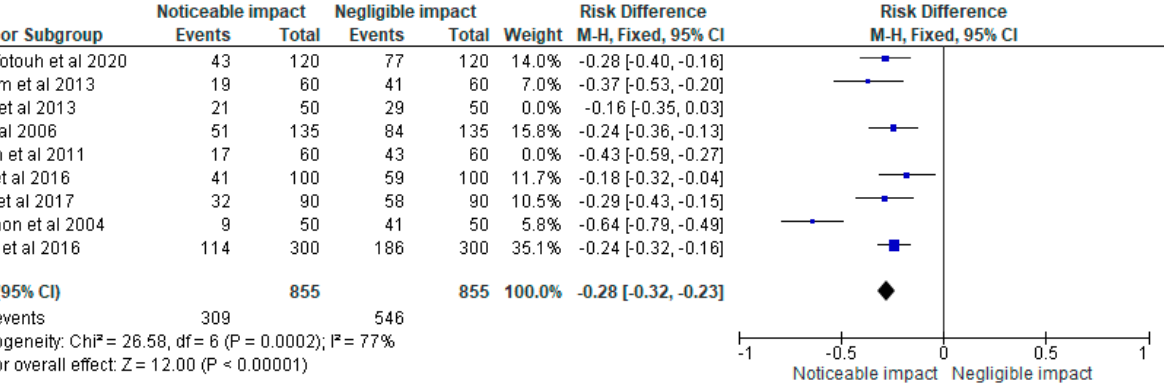
Figure 4. Risk difference representing the impact status of COS accentuation on masticatory effi- ciency in the clinical trials [2,18–25] selected for meta-analysis on a forest plot (assuming a 95% con- fidence interval.